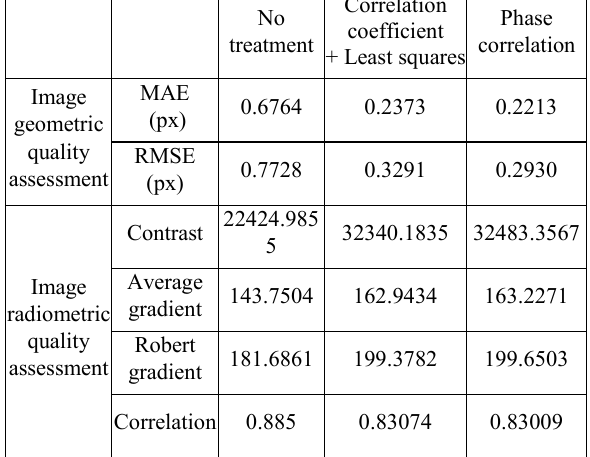
Table 3 . Assessment for image